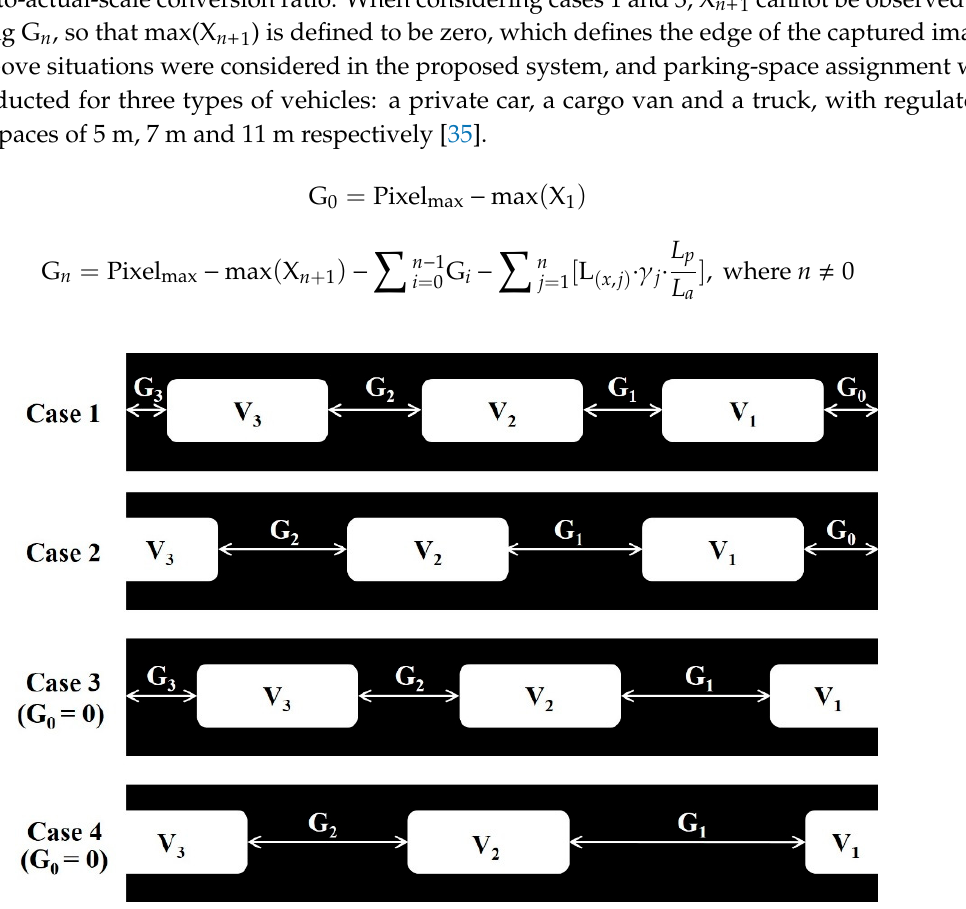
Figure 8. Four possible cases for capturing images.